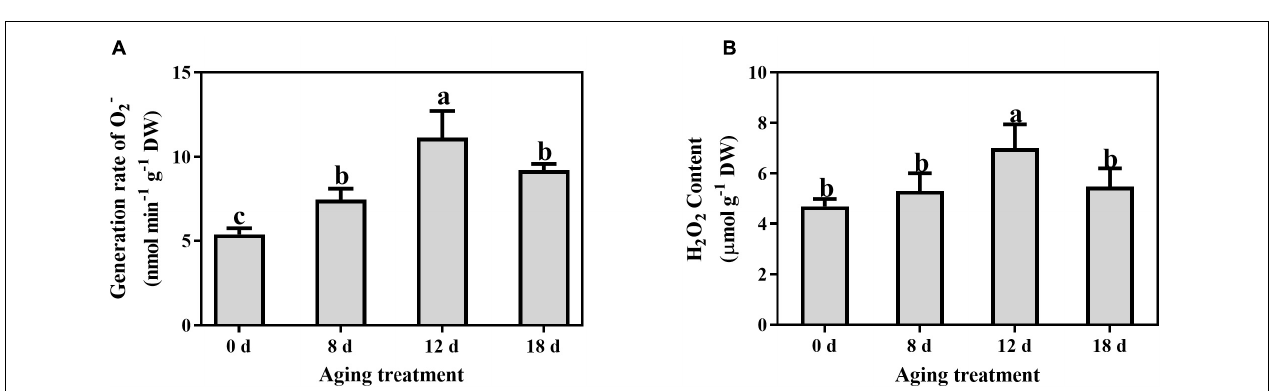
FIGURE 2 | Effects of artificial aging treatment on the (A) AsA and DHA contents, and (B) GSH and GSSG contents. Data shows the mean ± SD of three biologically independent experiments. Columns marked with different letters (a-c) are statistically significantly different ( p < 0.05).